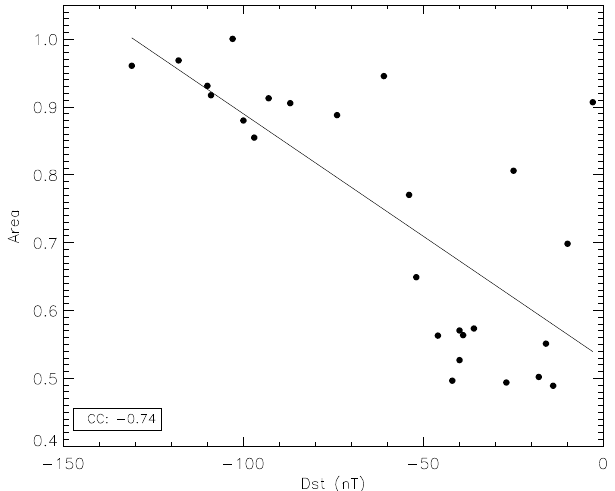
Figure 16. The relationship between the area of CRW and the Dst index during different time of geomagnetic storm on 21 Jan- uary 2012. The y axis has been normalized. This figure shows that there is no simple linear relationship between the area of CRW and the Dst index.